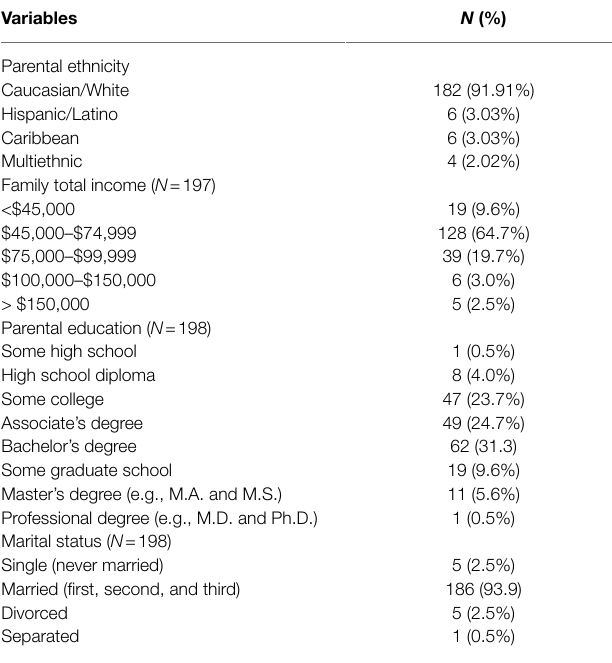
TABLE 1 | Demographics: ethnicity, family total income, parental education, and marital status. Variables N (%) Parental ethnicity